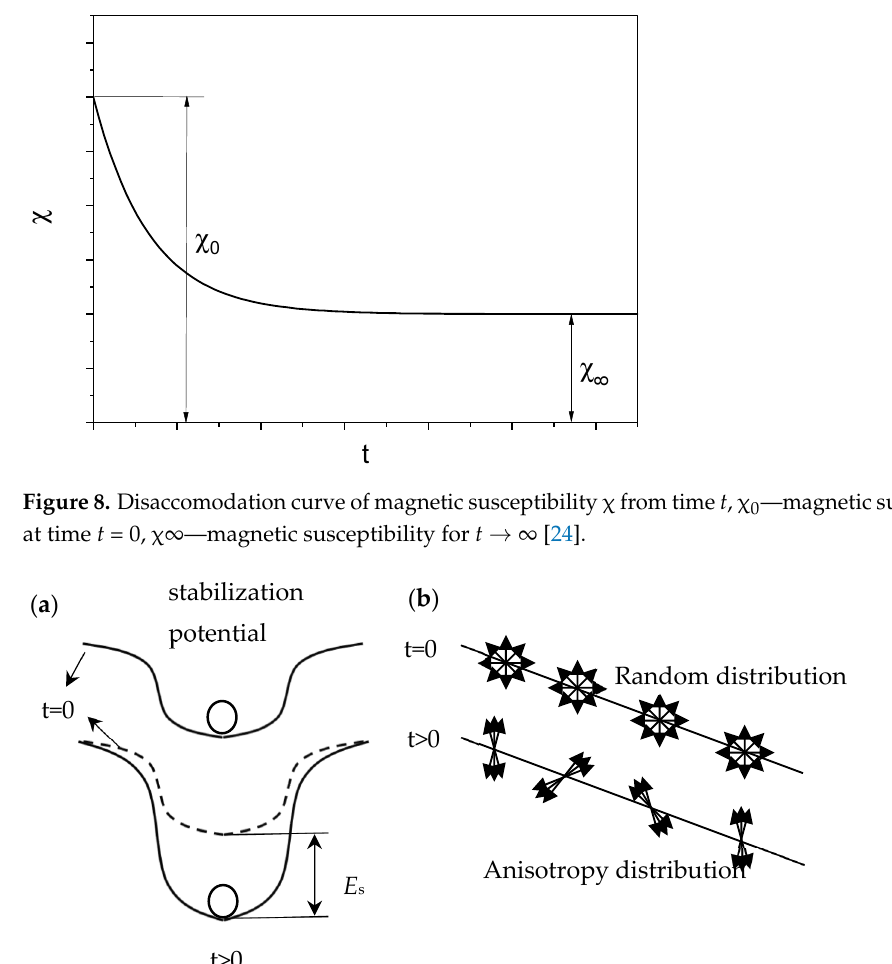
t [s] Figure 10. Magnetic permeability μ r from time t after demagnetization; Webb–Ford effect in silicon steel, curve A for time t = 0 from the time of demagnetization, curves B, C, D—for later times ti. The phenomenon of magnetic delay can be caused by processes such as [24]: •